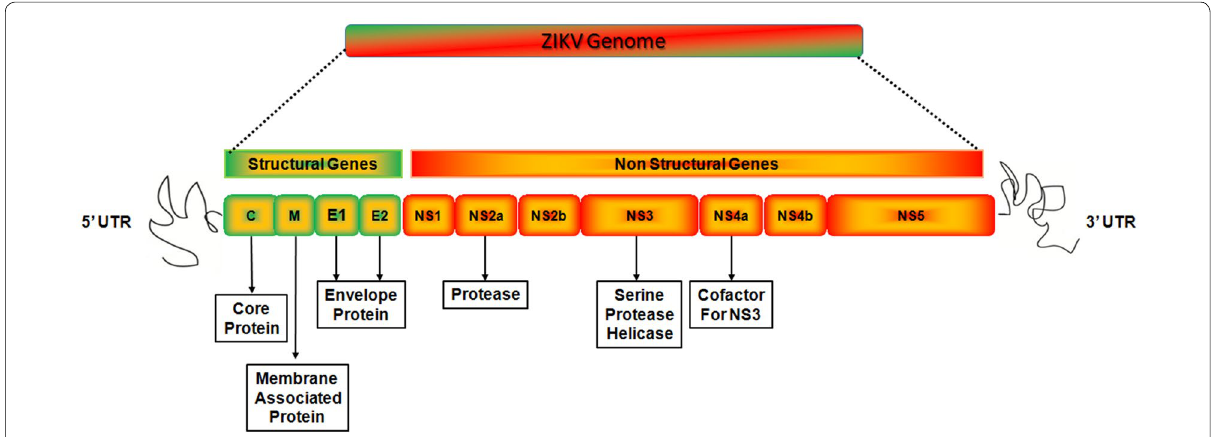
Fig. 2 The genome organization of